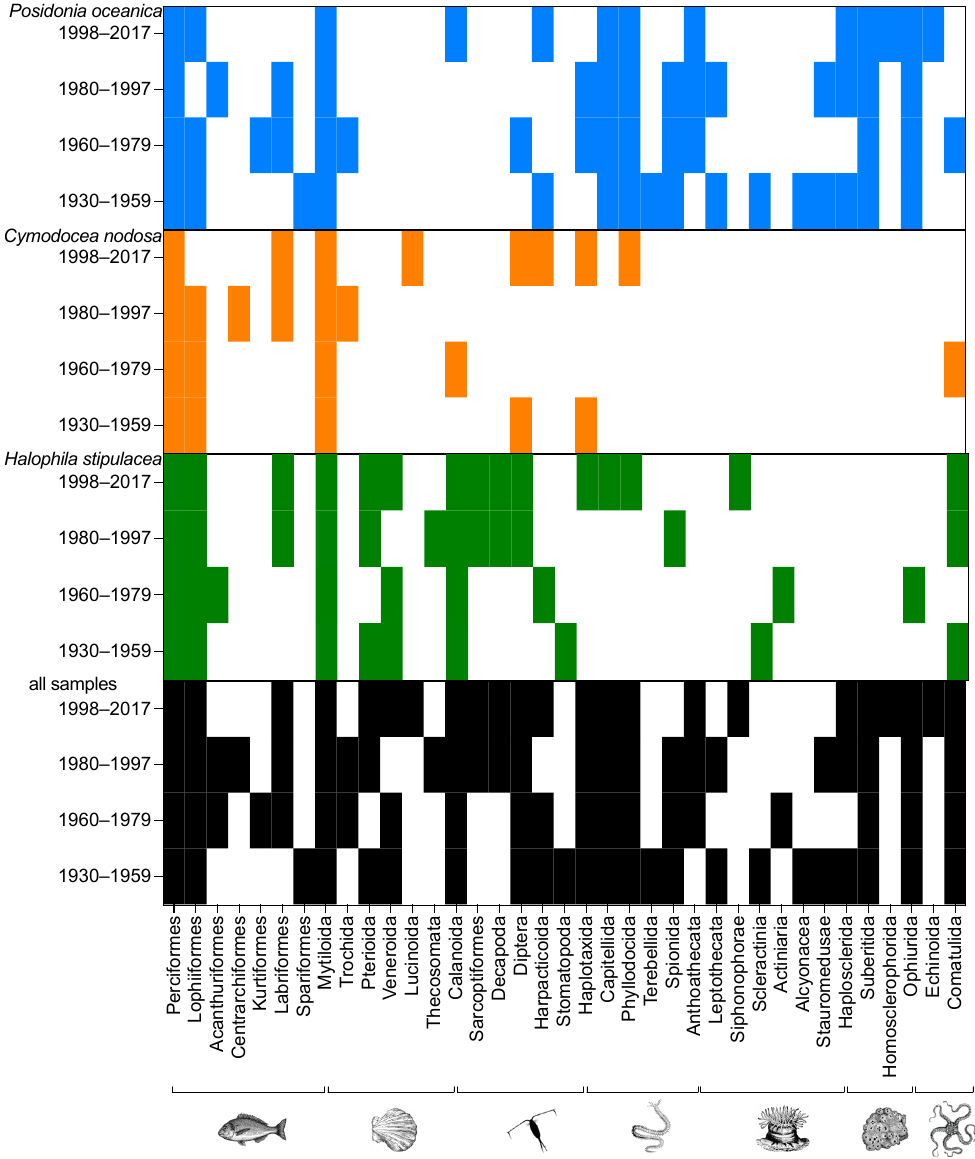
Figure 4. Heat map displaying the presence of metazoan orders through 4 different time periods within seagrass sediments (all samples in black; H. stipulacea in green; C. nodosa in orange; P. oceanica in blue) from the eastern Mediterranean Sea (Greece and Cyprus).